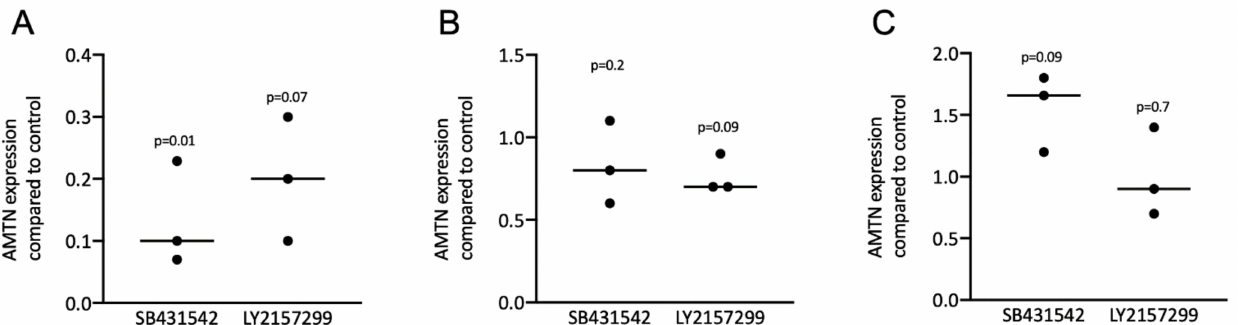
Figure 7. Inhibitors of T β RI downregulate expression of AMTN. RT-PCR analysis of the AMTN gene in the presence of SB431542 and LY2157299 showed decreased expression in comparison to untreated control in ( A ) HSC2, ( B ) TR146, and ( C ) GF. Statistics based on one-way ANOVA Kruskal–Wallis